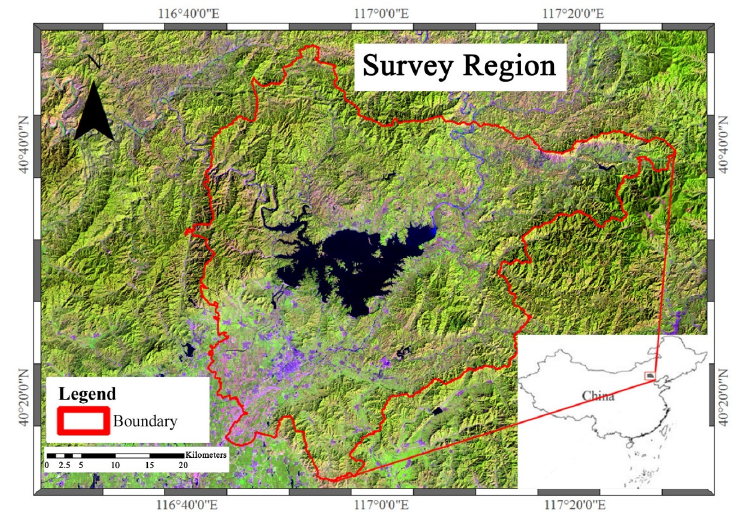
Figure 1. Location of the study area in China.